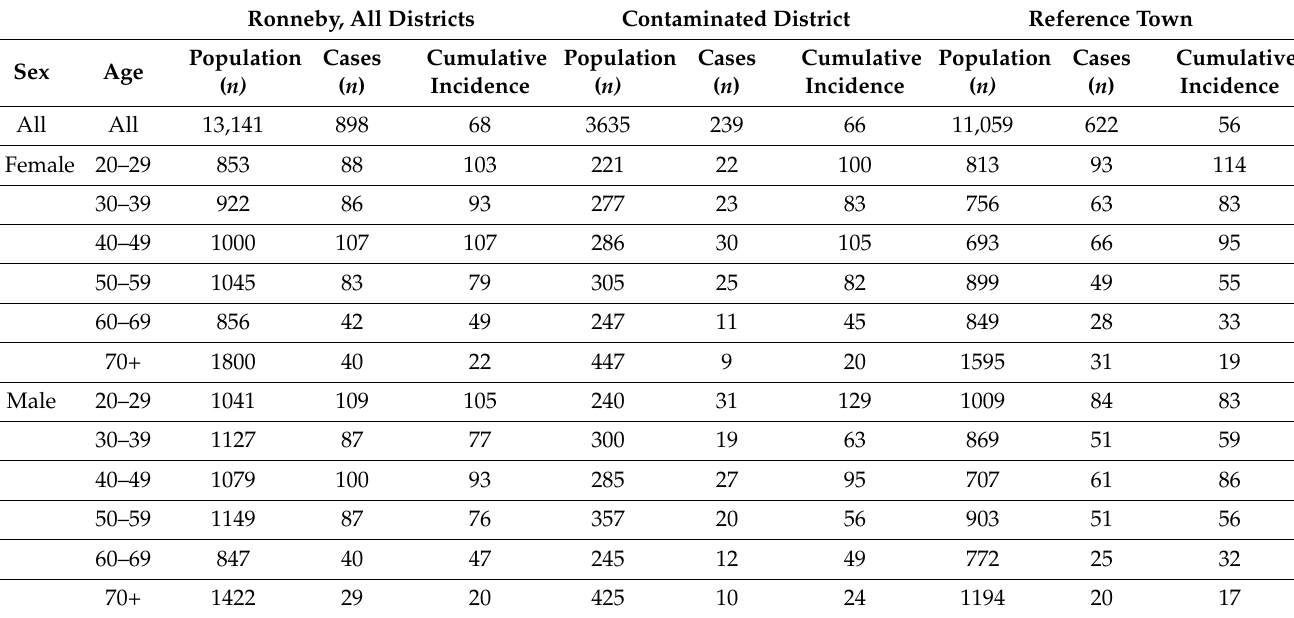
Table 1. Verified cases of COVID-19 in Ronneby (all districts together), in the contaminated district, and in the reference town together with the cumulative incidence per 1000 individuals.